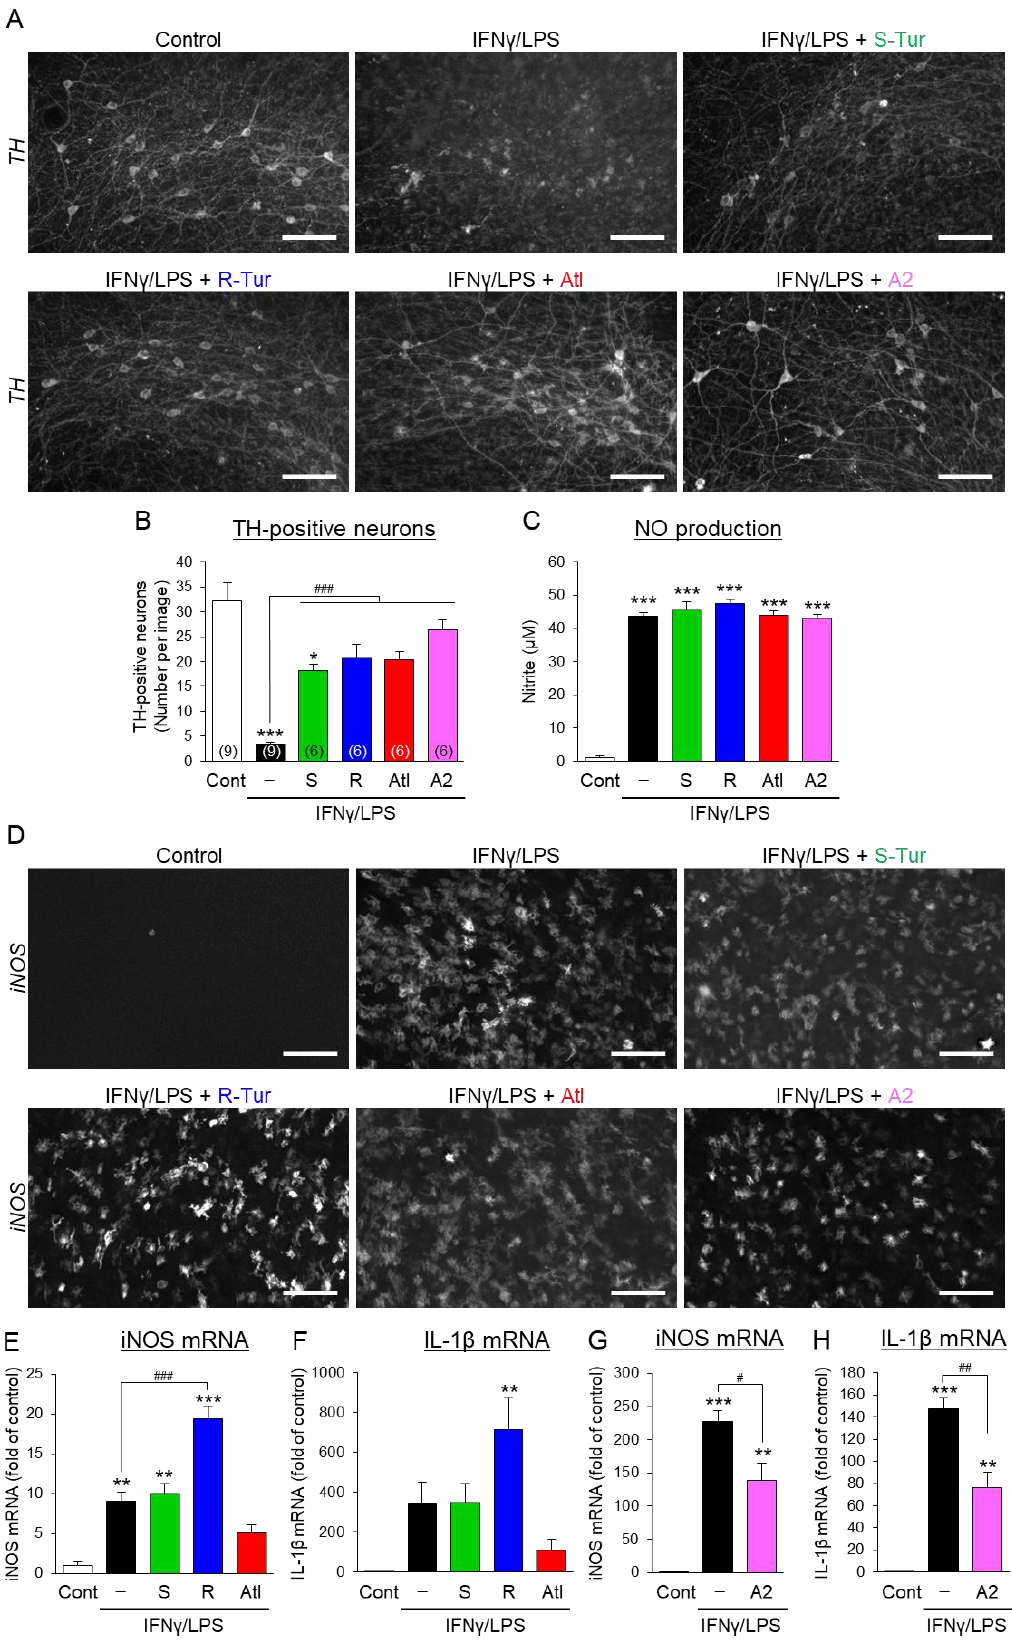
Figure 3. Effects of ar-turmerone analogs on dopaminergic neurodegeneration and microglial activation triggered by the treatment of IFN γ /LPS in midbrain slice cultures. ( A ) Representative images of TH immunoreactivity in midbrain